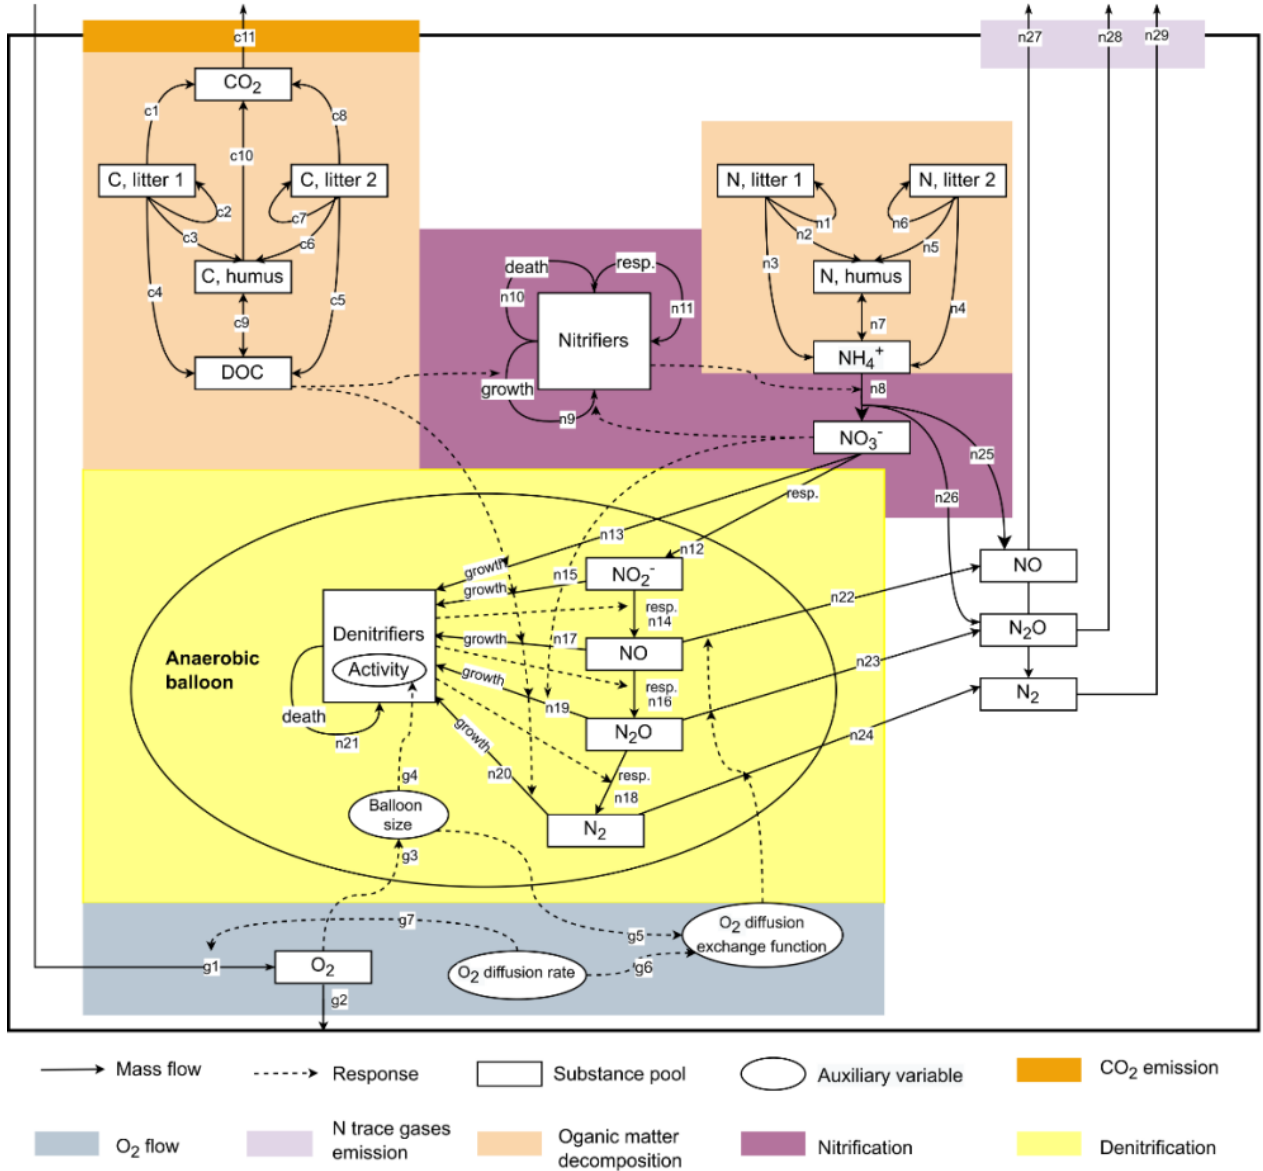
Figure 1. A conceptual diagram of major C and N processes in the current setup of CoupModel. The details of parameters and equations in each C or N process can be found in Table